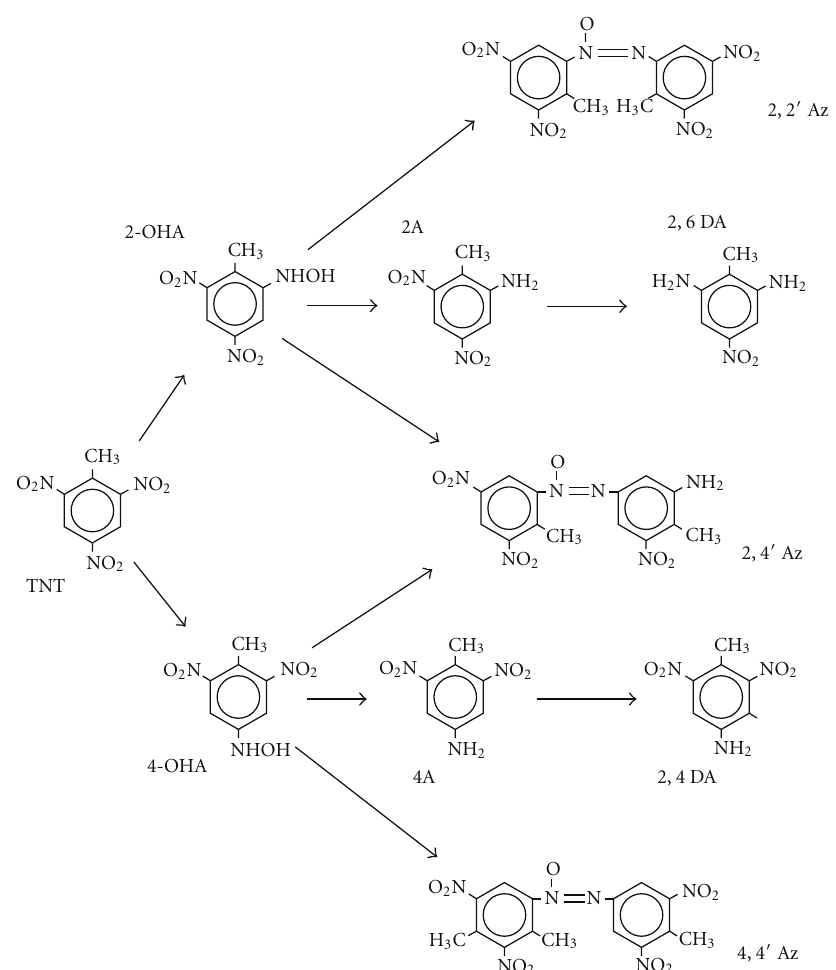
Figure 4: Biological transformation pathway of TNT [217]. Reproduced with kind permission from The American Society for Microbiology.